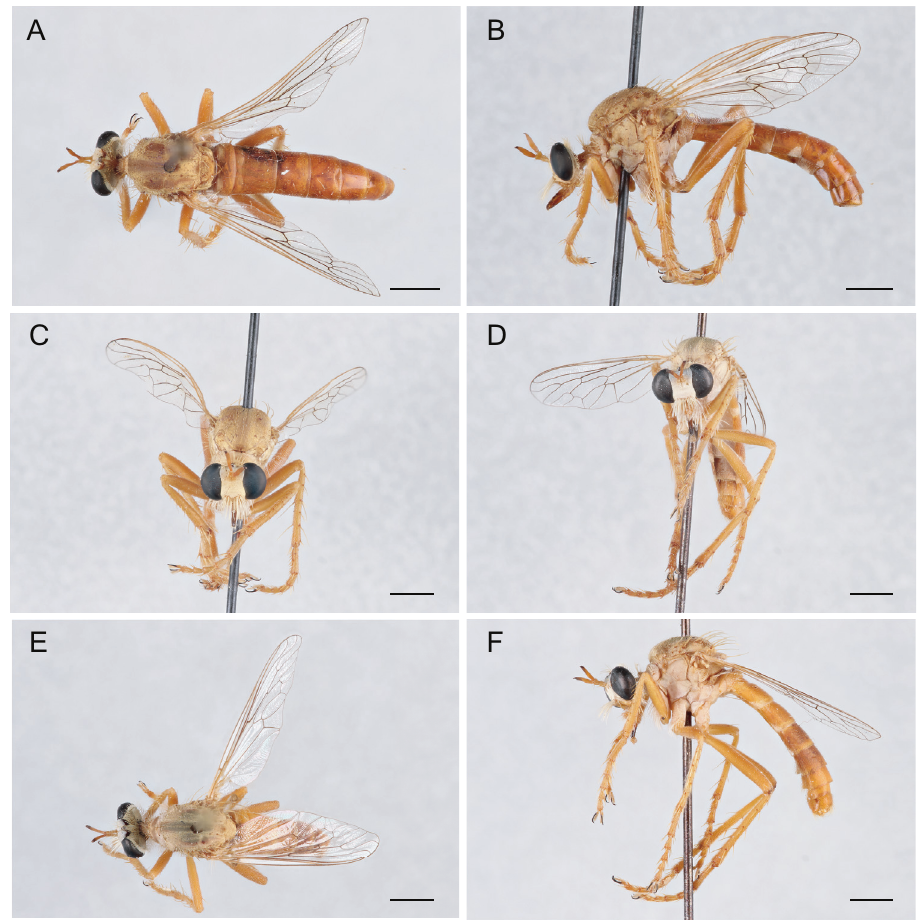
Figure 14. Saropogon hyalinus Coquillett, 1904 Female (USNMENT01830078): A dorsal view B lateral view C anterior view; Male (UCBMEP0280500): D anterior view E dorsal view F lateral view. Scale bars: 2